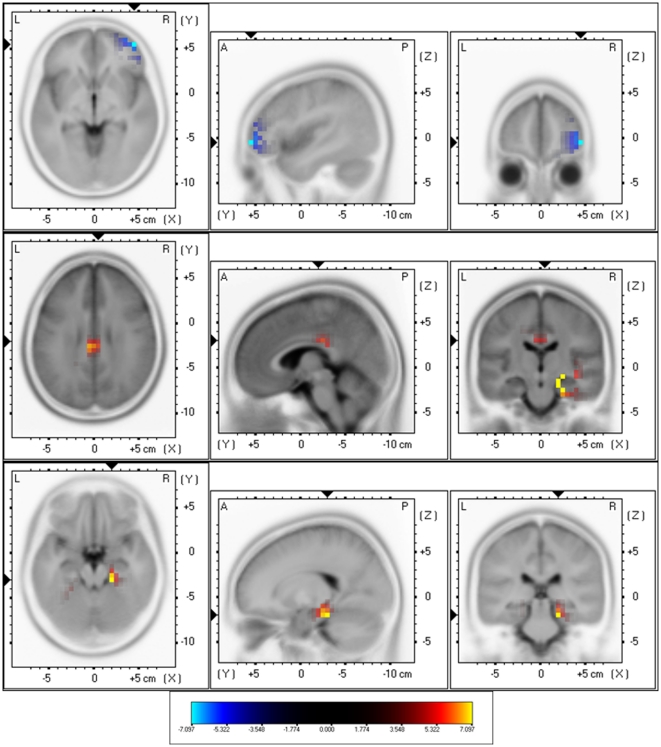
sLORETA contrast analysis between Narrow-Band-Noise versus Pure Tone tinnitus (p<.05).Decreased activity within Delta (1–3.5 Hz; Top Panel) in the prefrontal cortex (BA10), and increased activity within Beta (25–30 Hz; Middle Panel) and Gamma (30.5–45 Hz; Bottom Panel) in respectively posterior cingulate cortex (PCC; BA23) and the right parahippocampal area (BA35) for patients presenting with bilateral narrow band tinnitus in comparison to bilateral pure tone tinnitus.